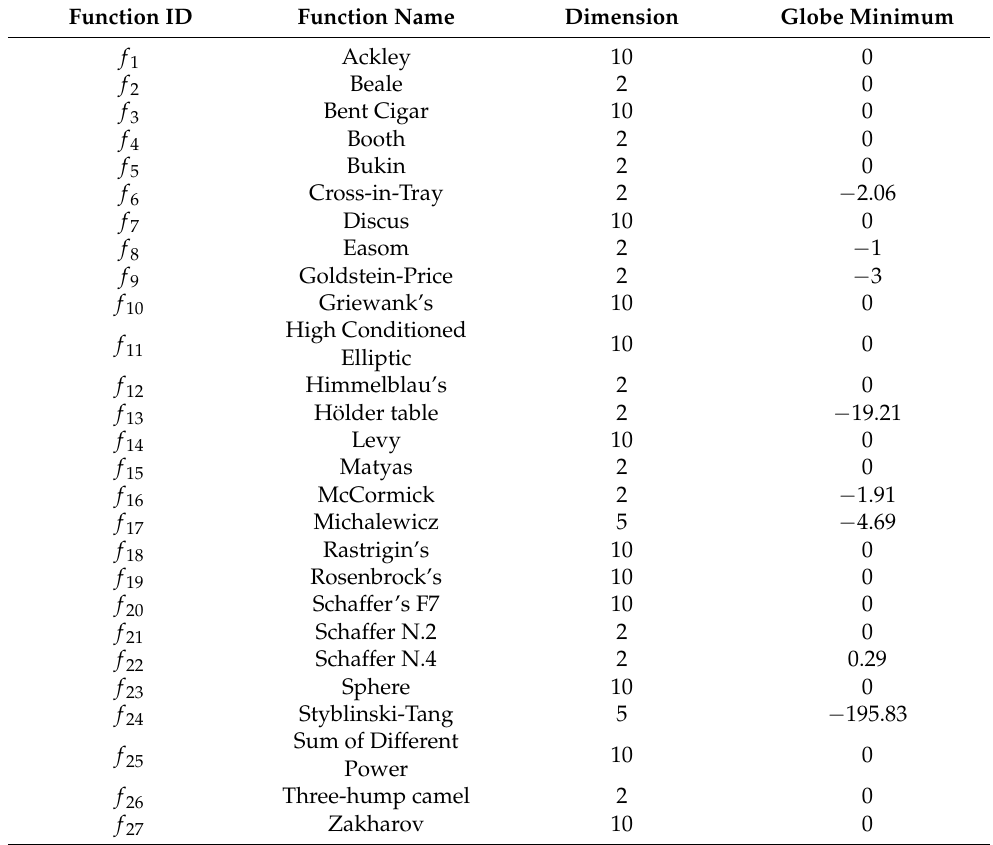
Table 1. Benchmark functions published by ICEC